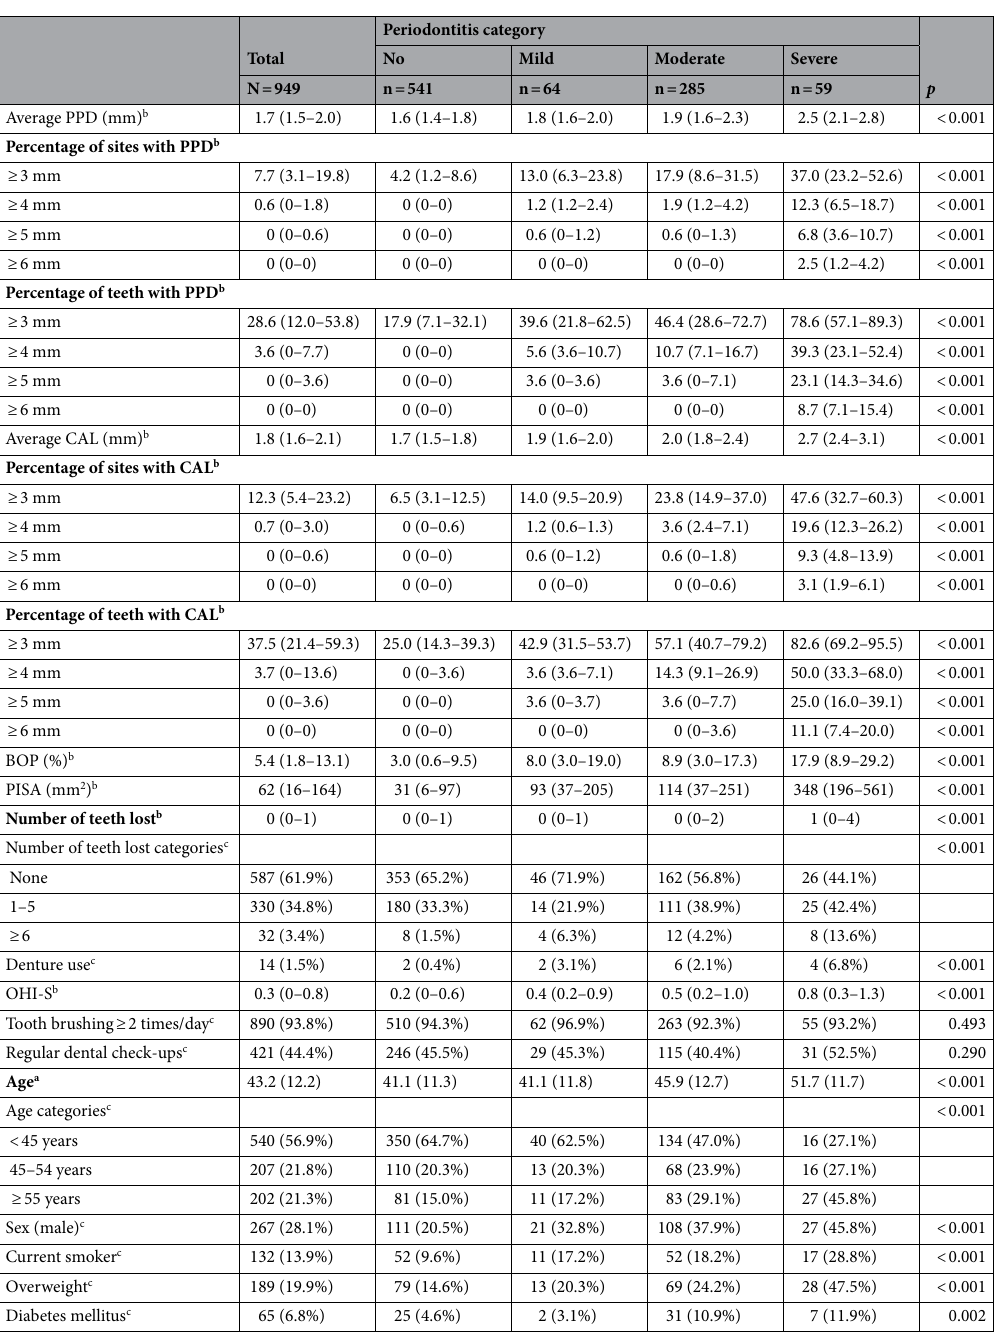
Table 1. Characteristics of the study population according to the CDC/AAP periodontitis definition. AAP, American Academy of Periodontology; BOP, bleeding on probing; CAL, clinical attachment loss; CDC, Centers for Disease Control and Prevention; IQR, interquartile range; OHI-S, simplified oral hygiene index; PISA, periodontal inflamed surface area; PPD, periodontal probing depth; SD, standard deviation. a Presented as mean (SD). b Presented as median (IQR). c Presented as N